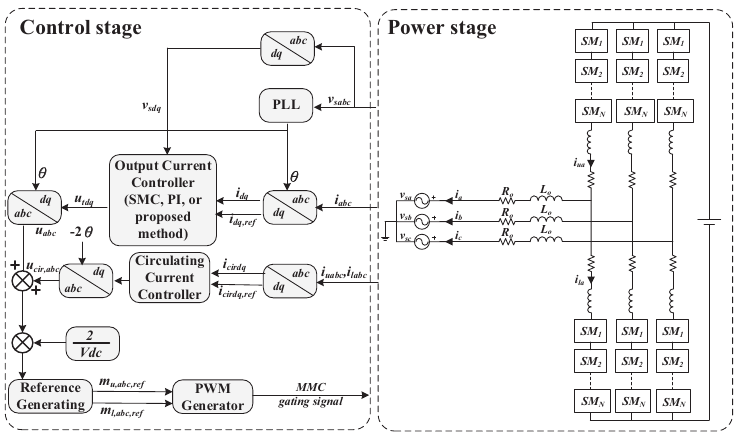
Figure 3. The general control strategy for MMC.